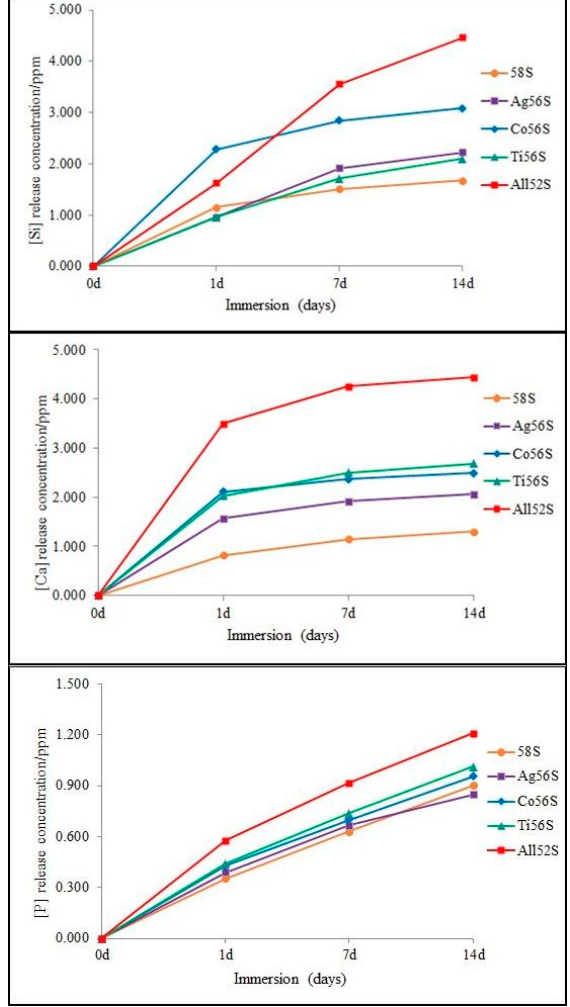
Figure 2. The Si, Ca and P ion release of the bioactive glass coatings after 1 d, 7 d, and 14 d of immersion in Tris–HCl solution.